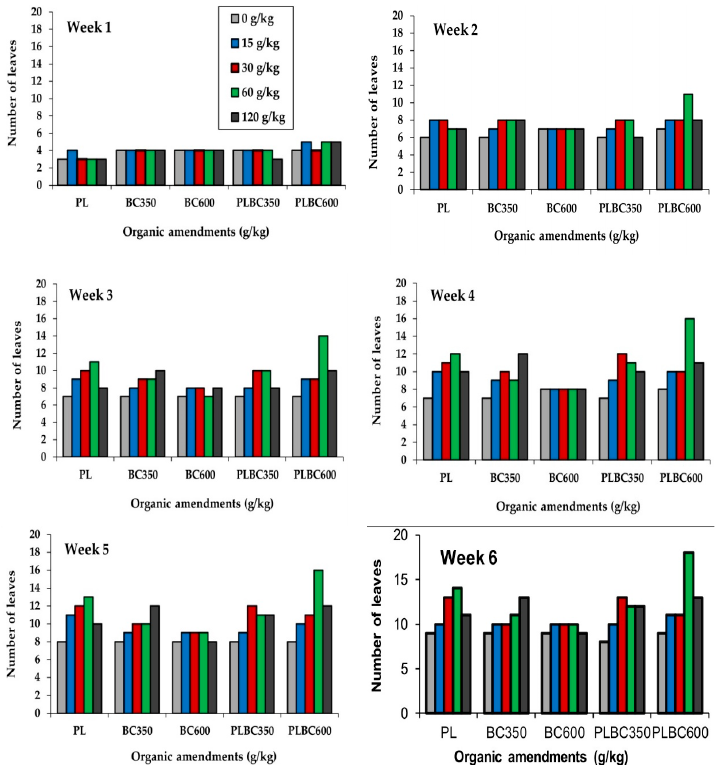
Figure 4. Effects of poultry litter and its biochar on the Jatropha number of leaves at different ap- plication rates (g/kg) of 0, 15, 30, 60, and 120 g/kg from week 1 to week